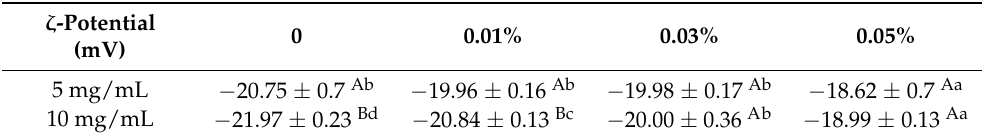
Table 2. Effects of TPP on the ζ -potential of MP O/W emulsions.